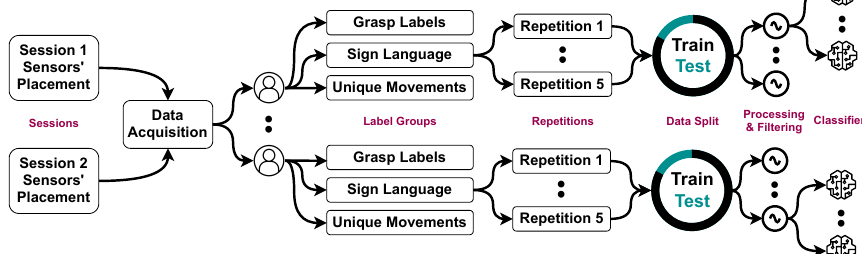
Figure 3. A diagram showing the breakdown of the data categories in the